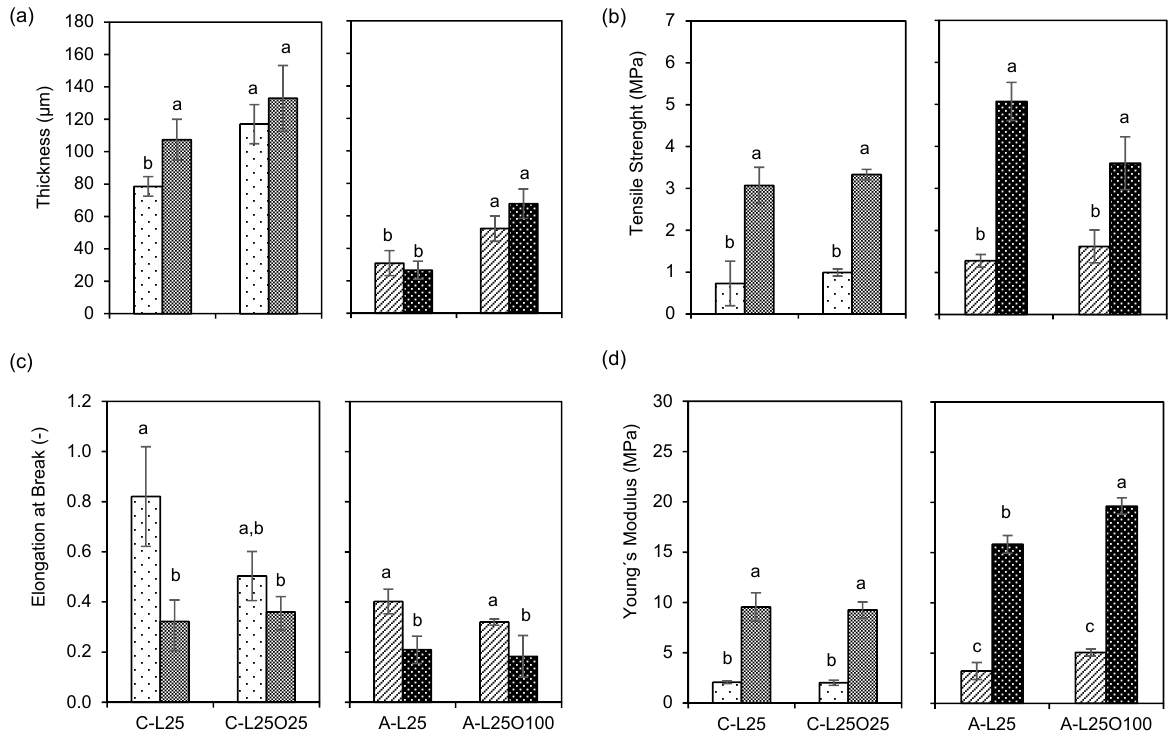
Figure 5. Values of the thickness ( a ), tensile strength ( b ), elongation at break ( c ) and Young’s modulus ( d ) for uncrosslinked and crosslinked selected films (C-L10O25, C-L25O25, A-L10O100 and A-L25O100), along with that of their uncrosslinked and crosslinked counterparts without oil (C-L10, C-L25, A-L10 and A-L25). Lighter and darker bars refer to non-crosslinked and crosslinked films, respectively, and indicate the mean ± standard deviation. Means in bars with different letters are significantly different ( p < 0.05), based on Tukey's test.